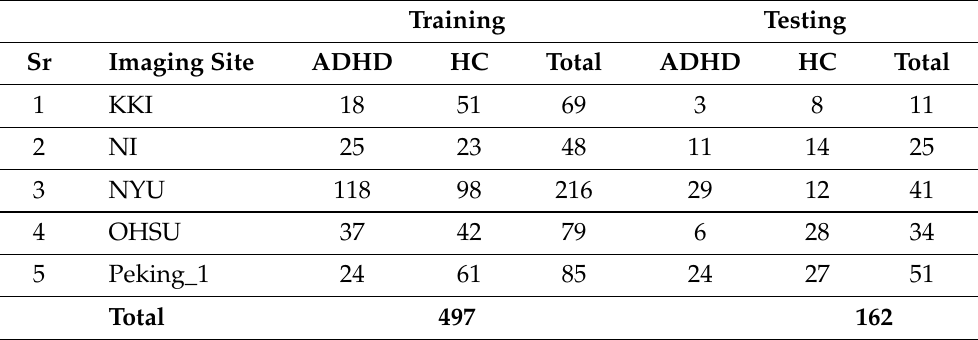
Table 1. ADHD-200 Preprocessed